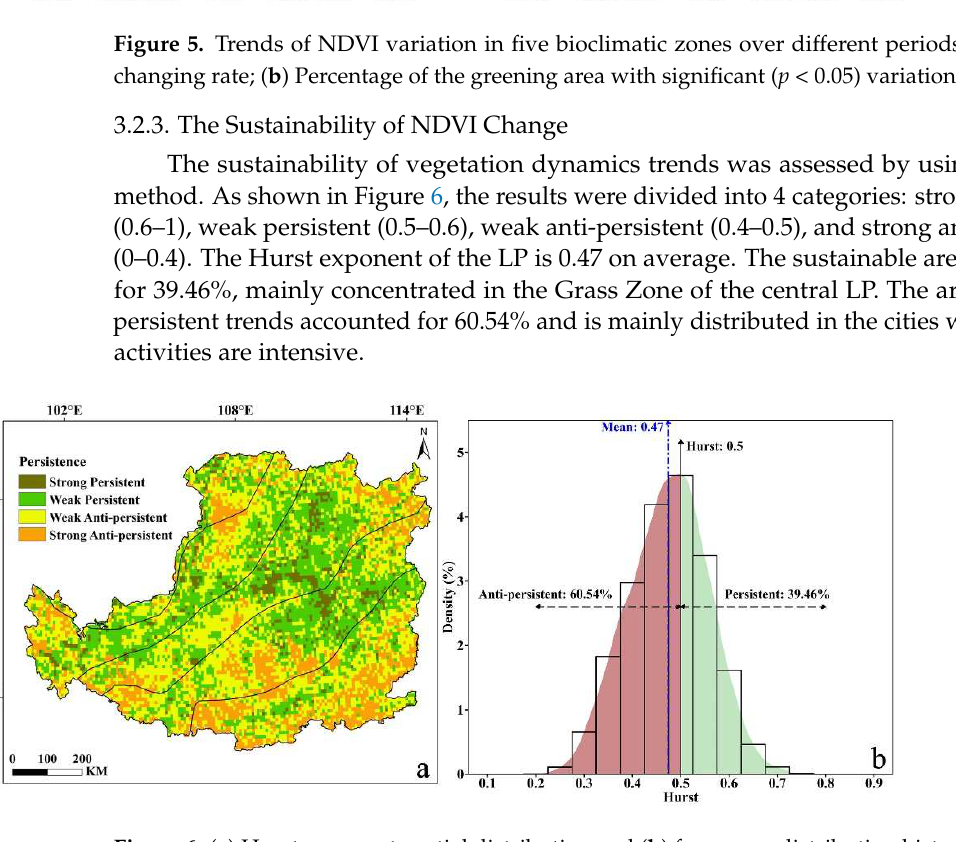
Figure 6. ( a ) Hurst exponent spatial distribution and ( b ) frequency distribution histogram.